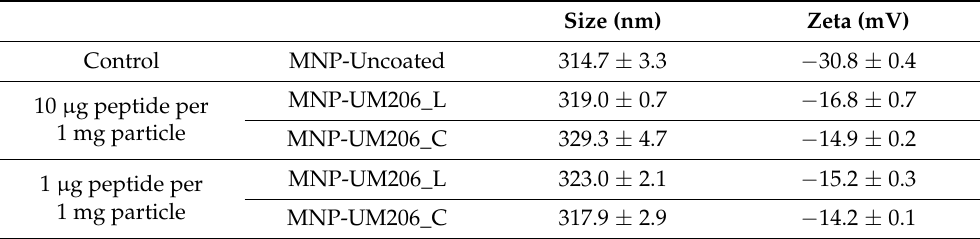
Table 1. Size and surface potential of MNP with or without peptide